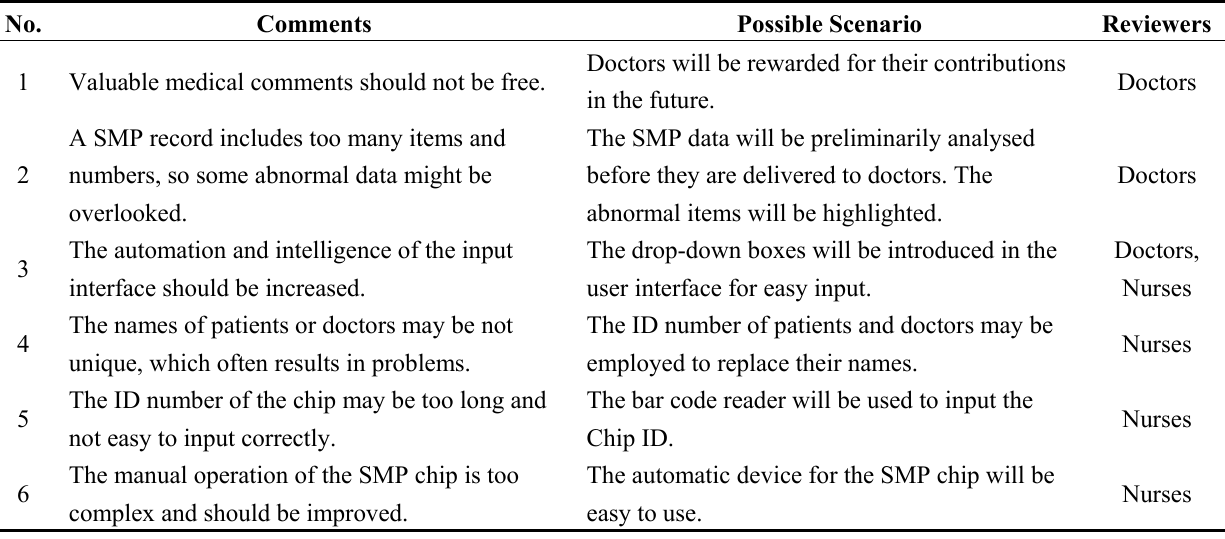
Table 1. Comments on the demo HSMPD system from doctors and nurses (six doctors and four nurses